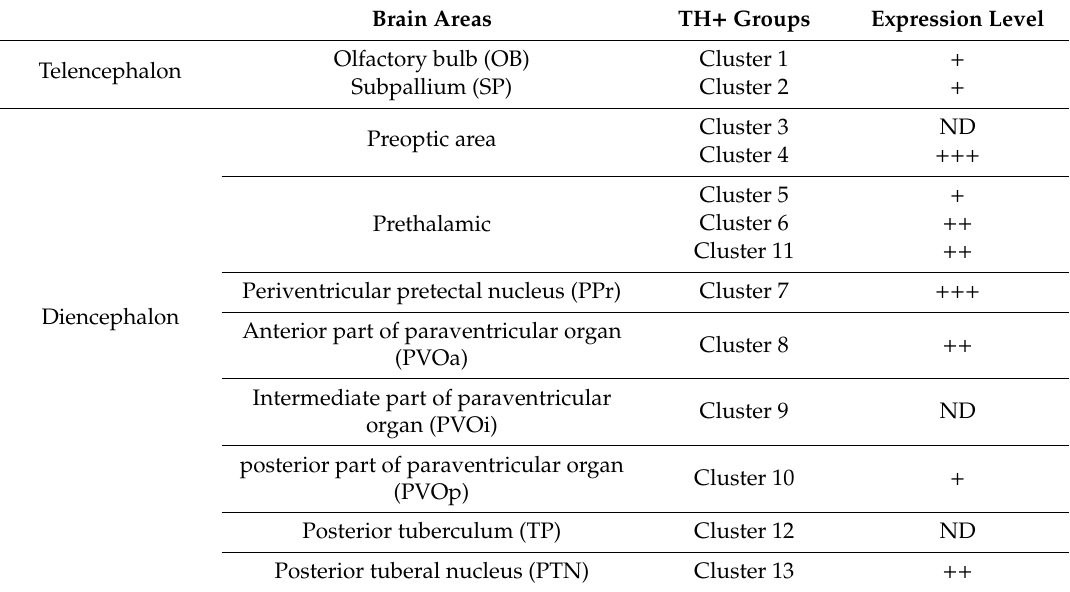
Table 2. Qualitative analysis of gdnf expression in TH immunoreactive neurons in the adult zebrafish